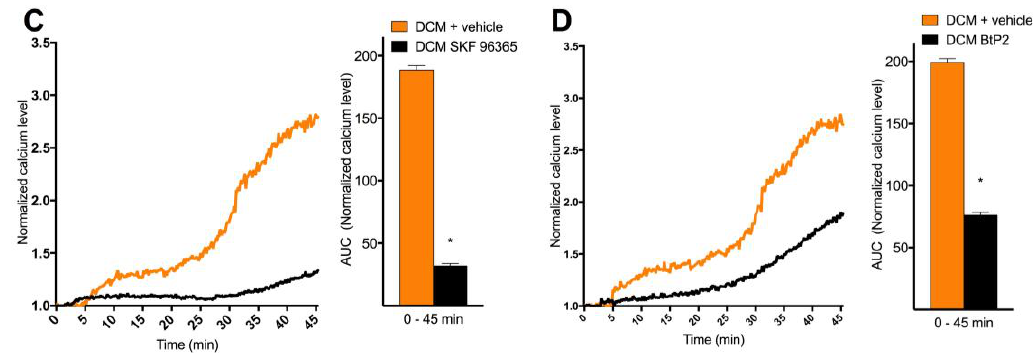
Figure 4. Mechanisms and channels involved in n -Hex- and DCM-EOM-induced [Ca 2+ ] i . Cells were incubated in a buffer with or without the calcium inhibitors (i.e., 10 μM SKF 96365 or 10 μMBtP2) 30 min prior to exposure. Three min after measurements were started, the cells were exposed to n -Hex- ( A , B ) or DCM-EOM ( C , D ) at concentrations corresponding to 5 μg/mL of the original DEPs or vehicle control (DMSO). [Ca 2+ ] i level measured by normalized ratio of the Fura2-AM probe during exposure are presented as a graph, and AUC from 1.0 at the Y -axis and 0–45 min, as mean and mean ± SEM ( n = 3), respectively. * Significantly different from no inhibitor ( p < 0.05).